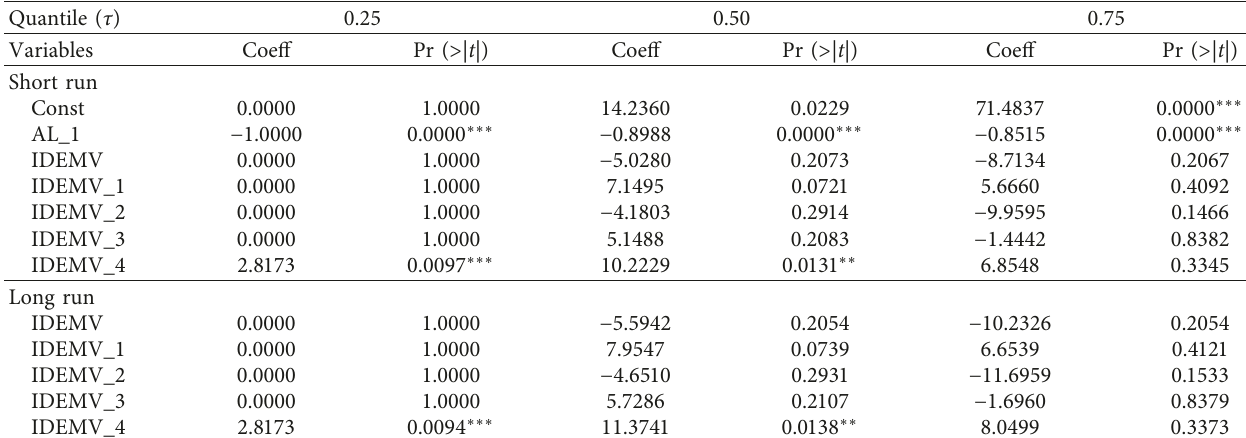
Table 6: QARDL estimation results: tranquil period (independent variable: IDEMV).